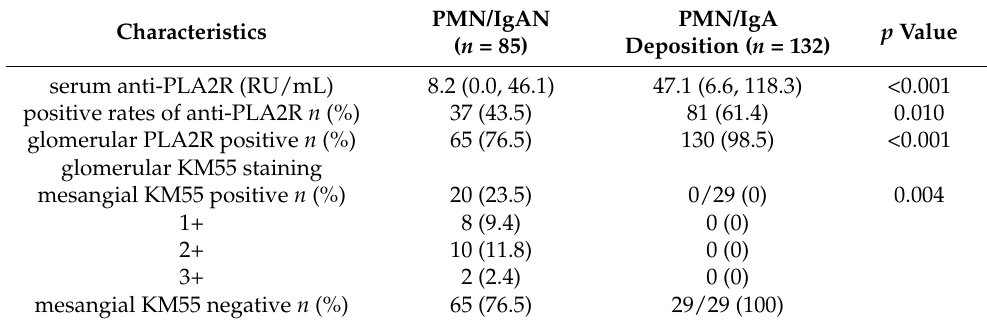
Table 3. Disease-specific pathogenic biomarkers for patients with PMN/IgAN.